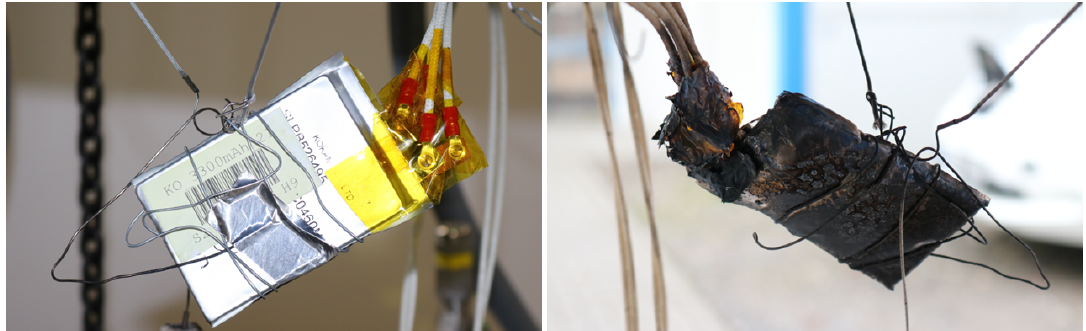
Figure 7. Experiment HT1: Left: Cell with applied temperature sensors before the experiment. Right: Cell after the experiment.